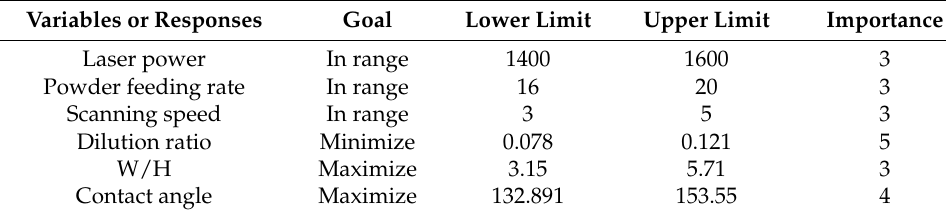
Table 8. Conditions and targets of optimization.